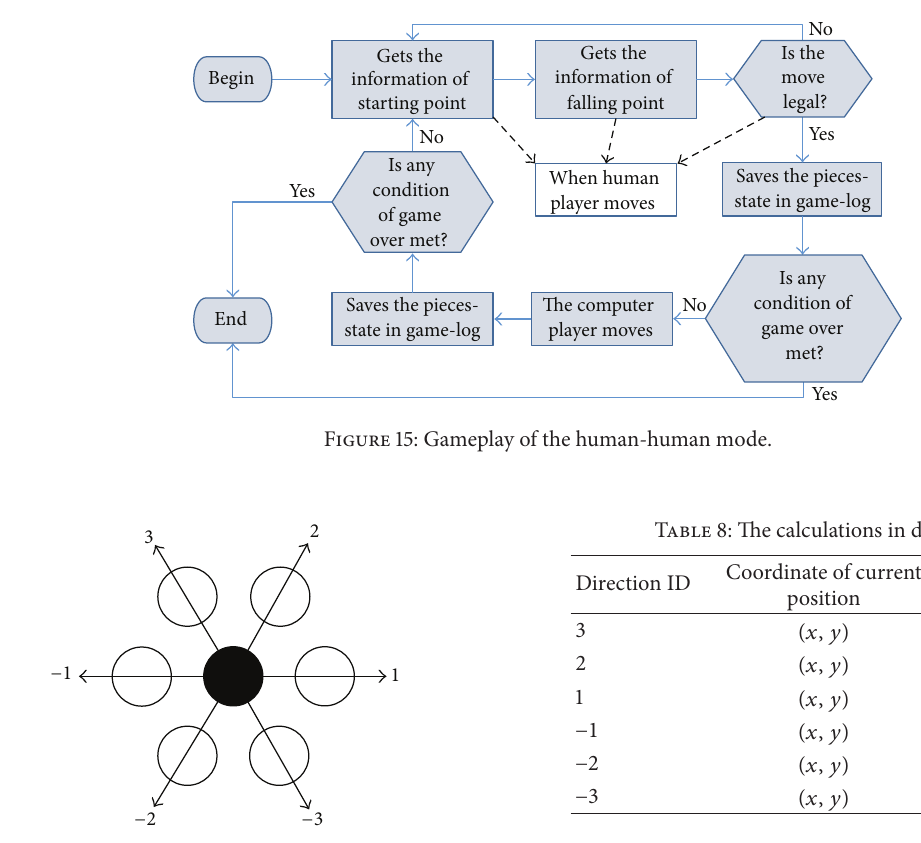
Figure 16: Searching directions.